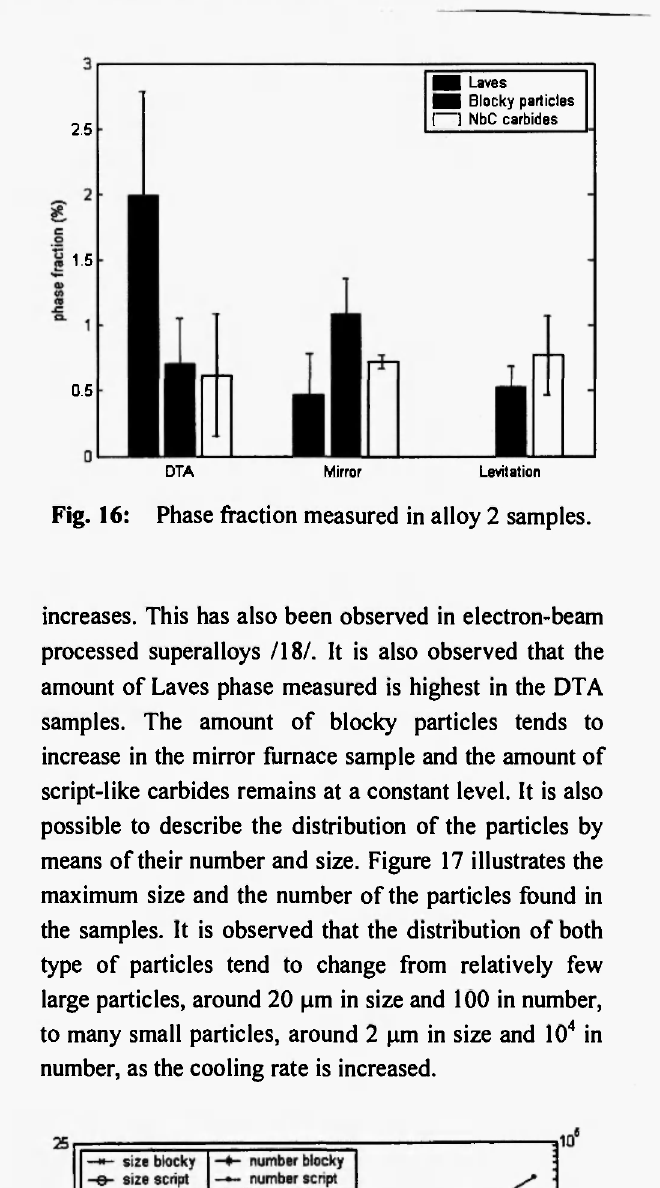
Fig. 15: Microstructure of a quenched sample of alloy 2 (Fs = 0.34).